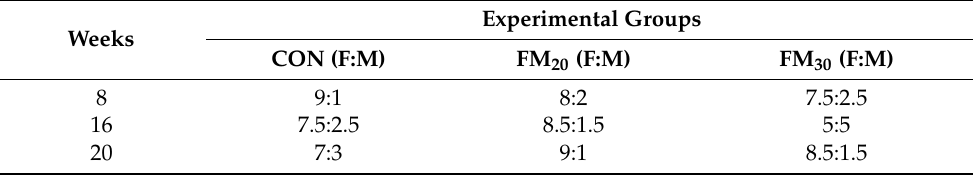
Table 6. Results of olive flounders ( Paralichthys olivaceus ) sex ratio from three experimental groups. F, female; M,